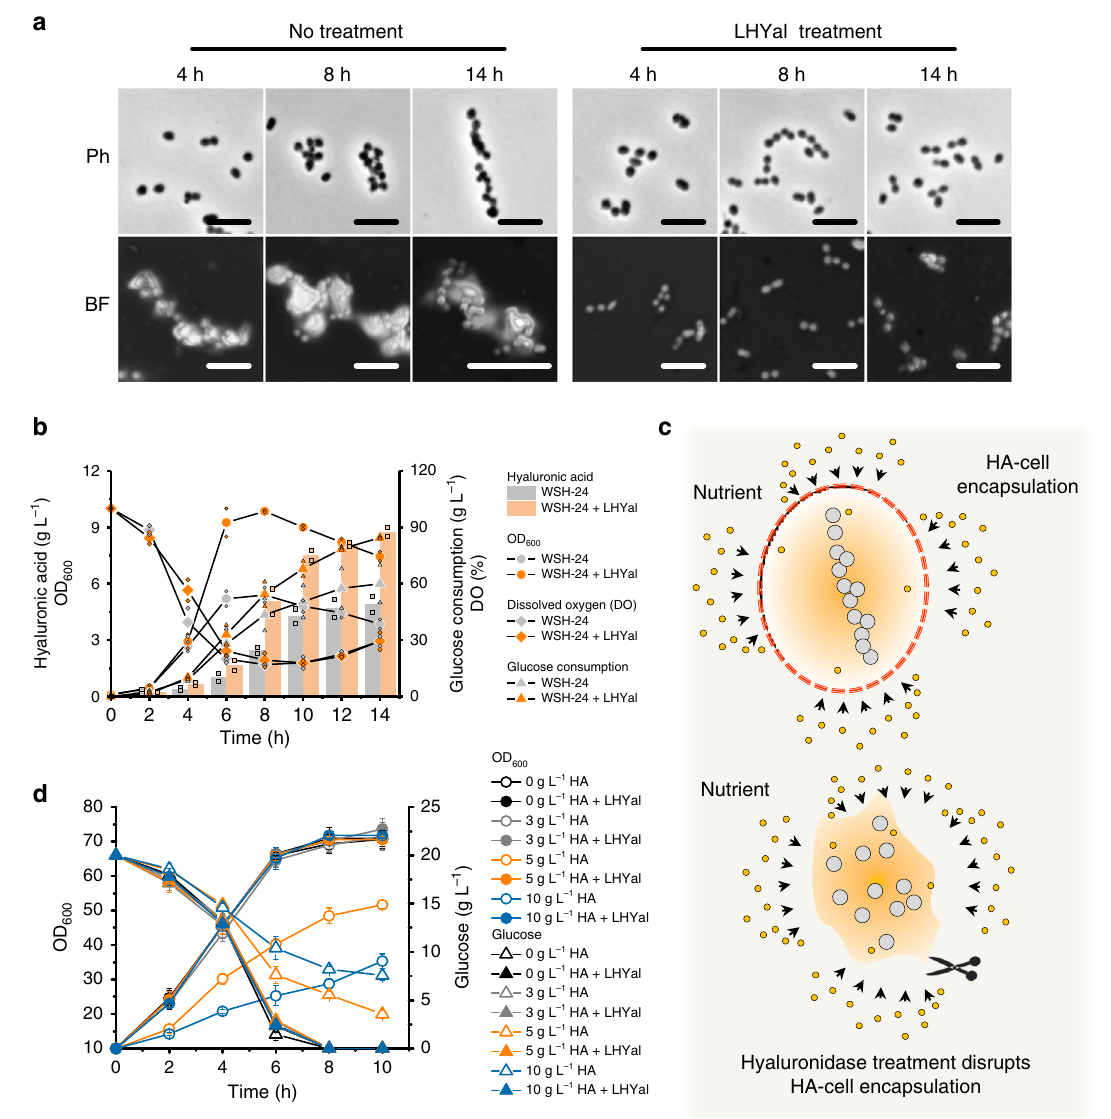
Fig. 4 The HA encapsulation inhibits cell growth and glucose uptake. a Representative micrographs of HA-producing S. equi subsp. zooepidemicus WSH- 24 cultivated in a 3-L fermenter (refer to b for the cultivation details) in the presence or absence of 6000 U mL − 1 of LHYal. Ph, phase-contrast microscopy; BF, bright- fi eld microscopy. Scale bar, 2.5 μ m. Microcopy experiments were performed two times independently with similar results. b S. equi subsp. zooepidemicus WSH-24 cultivated by fed-batch cultivation in a 3-L fermenter to produce HA in the presence of an initial glucose concentration at 70 g L − 1 and post-inoculation glucose concentration at between 10 and 15 g L − 1 . Total consumed glucose instead of real-time glucose concentration was plotted. LHYal (6000 U mL − 1 , fi nal concentration) was added at the beginning of cultivation. c A schematic showing HA encapsulation hinders nutrient uptake. LHYal inhibits HA encapsulation and increases nutrient availability. d Effect of HA dissolved in culture broth (weight average MW 1.3 MDa) on glucose uptake by wild-type C. glutamicum ATCC 13032. b The data are expressed as the mean from two ( n = 2) biologically independent replicates. Each biological replicate of HA concentration assay is presented as the mean value of three technical repeats. The values of each biologically independent replicate are indicated with same-colored symbols with smaller size. d The data are expressed as the mean ± SD from three ( n = 3) biologically independent replicates. Source data underlying Fig. 4a, b and d are provided as a Source data fi